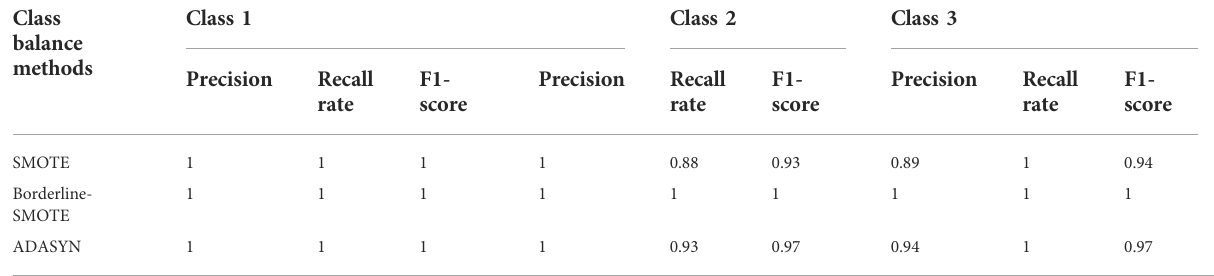
TABLE 6 Comparison of class balance methods with different classes using the Iris dataset.